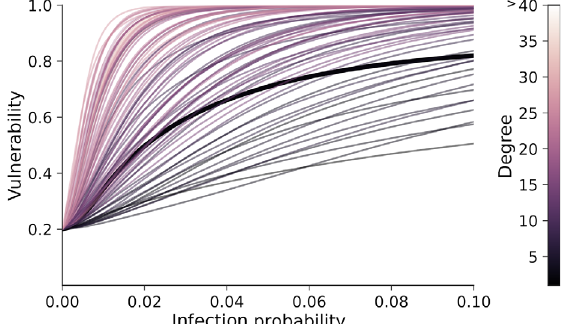
FIG. 17. Vulnerability as a function of the infection probability β estimated from the CB model. Each curve represents the vulnerability of a node, i.e., the probability to contract the infection from a set of randomly chosen outbreak locations. Here, we estimate the vulnerability according to the CB model. Starting from an initial infection probability of 1 − z ¼ 0 . 2 , we propagate the infection over time until convergence. We stop when the largest increase in vulnerability after 24 h falls below 10 − 3 . The colors indicate the degree of each node in the underlying time-aggregated graph. Moreover, the behavior of one selected node is